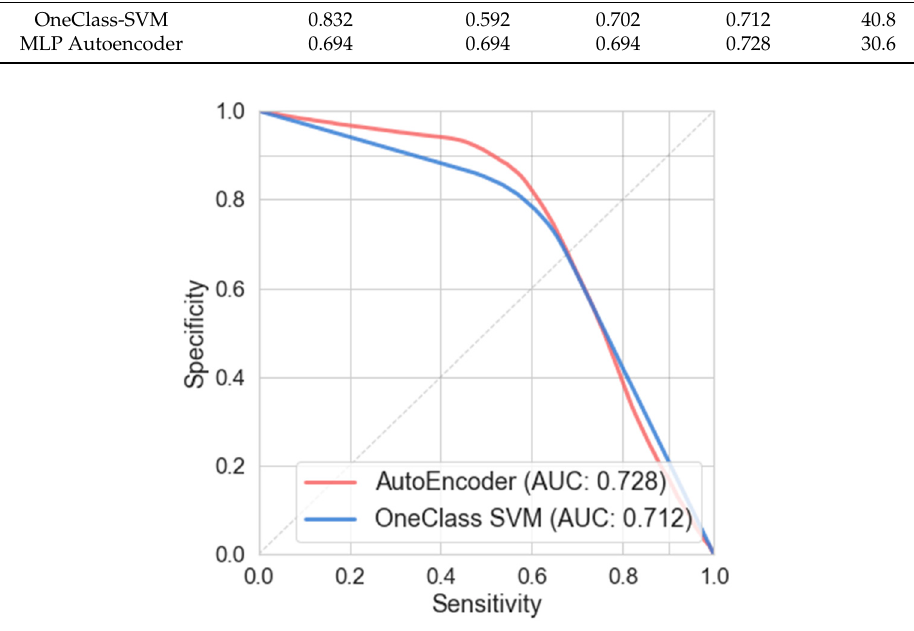
Figure 5. Specificity vs. sensitivity curves, an area under the curve (AUC), for two novelty detection algorithms with LOSO evaluation, using a 64-bin FFT data representation and 75% overlap.